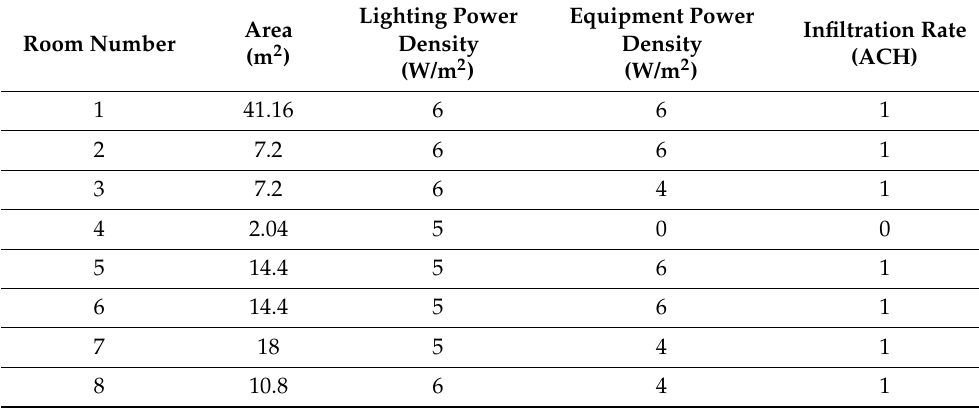
Table 5. Configuration details of other boundary conditions (adapted from